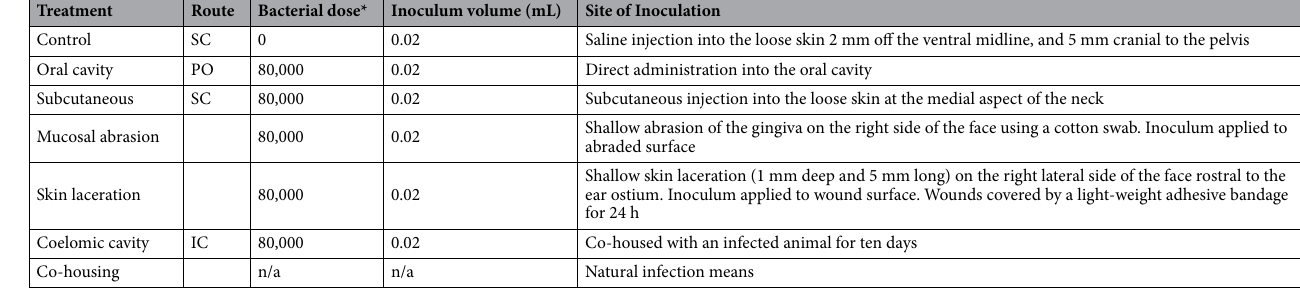
Table 1. The treatment groups used in the experimental infection trial. SC subcutaneous; PO per os; IC intracoelomic. *Total number of organisms administered per